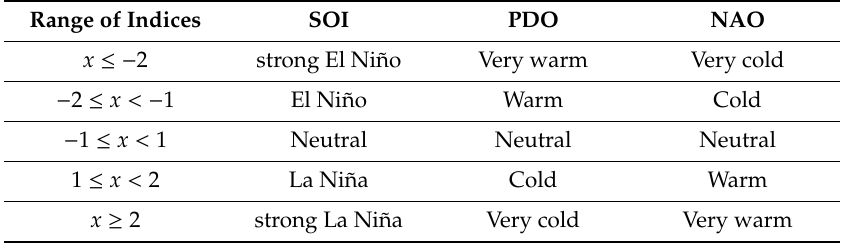
Table 1. Large-scale climate circulation indices classification. The x denotes the value of each index. Range of